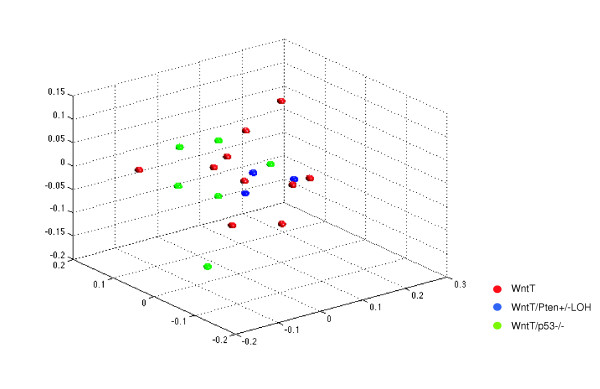
Multidimensional scaling analysis of 18 tumor samples of indicated genotypes. 8.7k arrays were used. MMTV, mouse mammary tumor virus; WntT, mammary tumors from MMTV-Wnt-1 transgenic mice; WntT/Pten+/- loss of heterozygosity (LOH), mammary tumors from MMTV-Wnt-1 transgenic/Pten+/- mice with Pten loss of heterozygosity; WntT/P53-/-, mammary tumors from MMTV-Wnt-1/P53-/- mice.